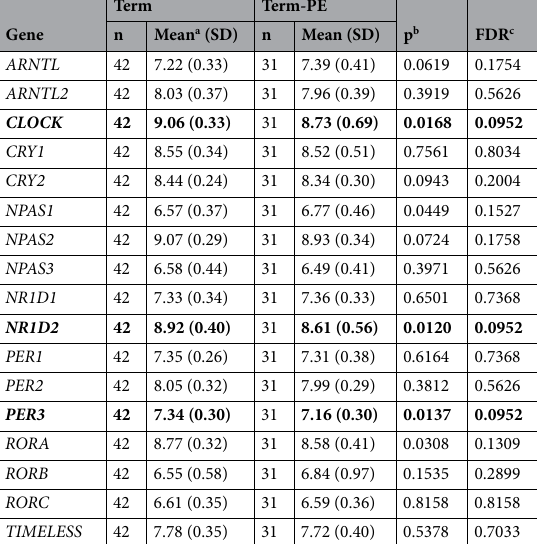
Table 4. Descriptive statistics of 17 candidate circadian genes’ expression levels in placenta from PE without PTB (Term-PE) vs. non-PE without PTB (Term) in GSE75010-157 dataset. a Mean of gene expression values, normalized and log2-transformed. Bold values denote statistical significance (p < 0.05 and FDR <